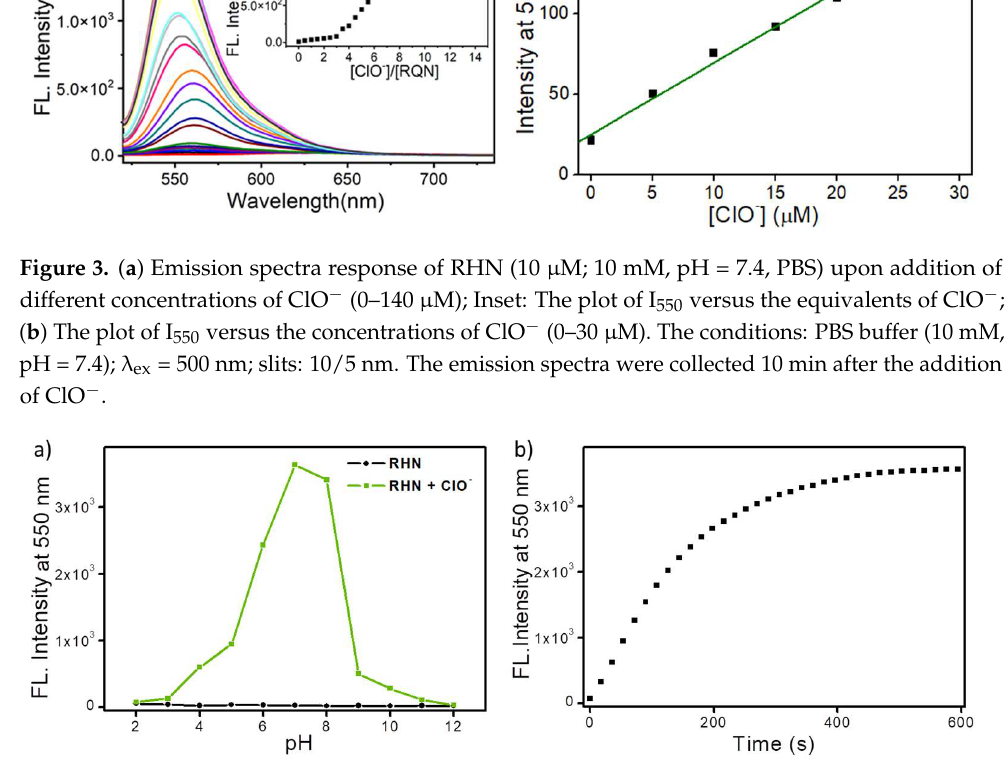
Figure 4. ( a ) Effect of pH on the fluorescence intensity of 10 μM RHN in the absence (black line) and presence of 100 μM ClO − (red line); ( b ) Time dependence of fluorescence intensity of RHN (10 μM) at 550 nm with 10 equiv. of ClO − . The conditions: PBS buffer (10 mM, pH = 7.4); λ ex = 500 nm; slits: 10/5 nm.